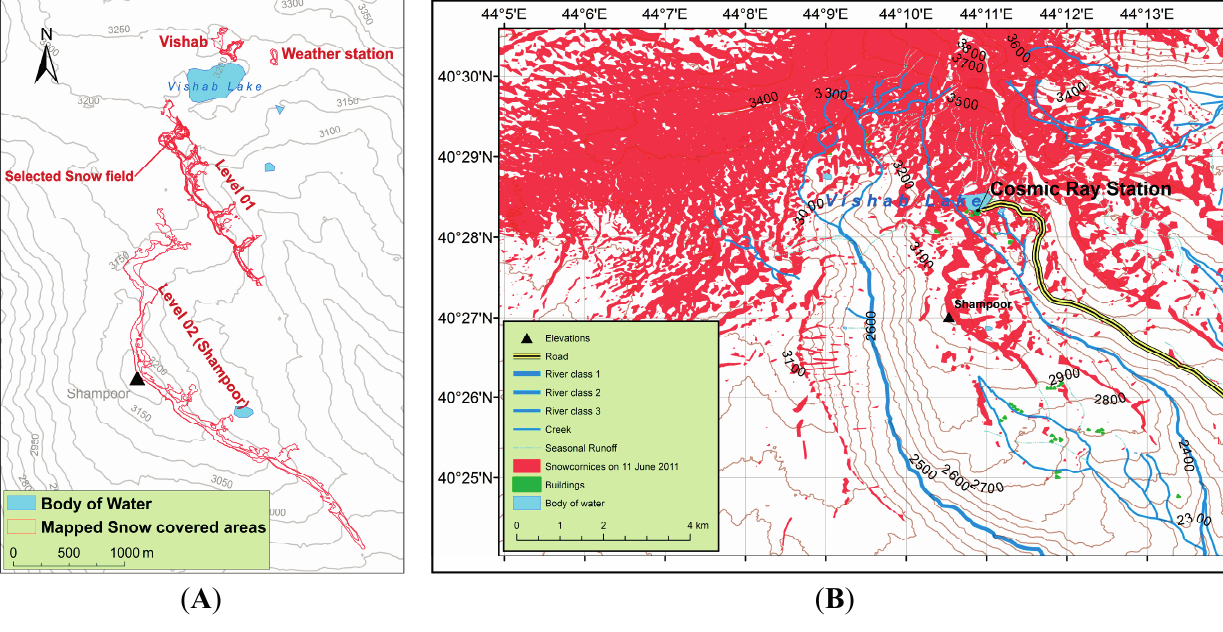
Figure 3. The observed distribution of wind directions on Mount Aragats during wintertime (November 2012–April